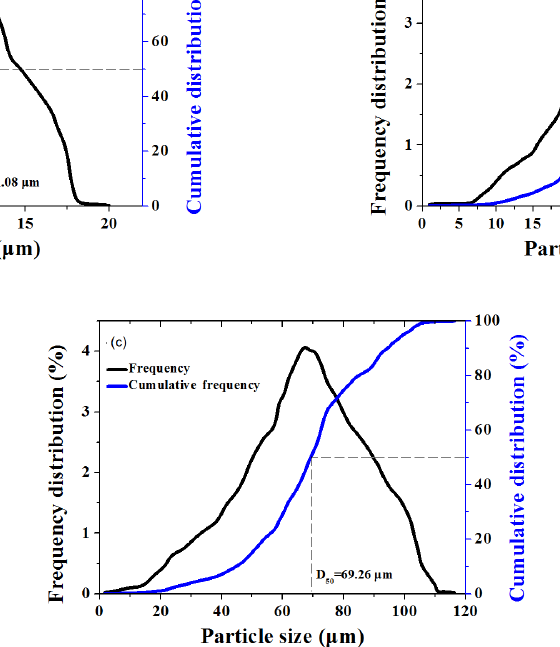
Figure 6. Size distribution of the arsenopyrite particles treated with ( a ) 0, ( b ) 40 and ( c ) 150 mg/L PEI-2. (Dotted line represents 50% cumulative yield corresponded particle